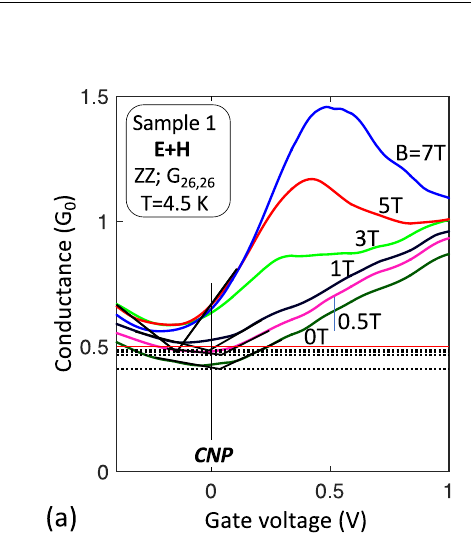
Fig. 4 | Magnetic fi eld effect on the edge state. a Conductance of Sample 2, Seg. B versus B for 4 values of V G (Fig. 3a vertical dashed lines) showing ≈ 0.1 G 0 dip at B =0 that is independent of V G (similar to Seg, C see SI5), indicating that the dip is relatedtoedgestatescatteringatthejunction(seetext). b ConductanceofSample